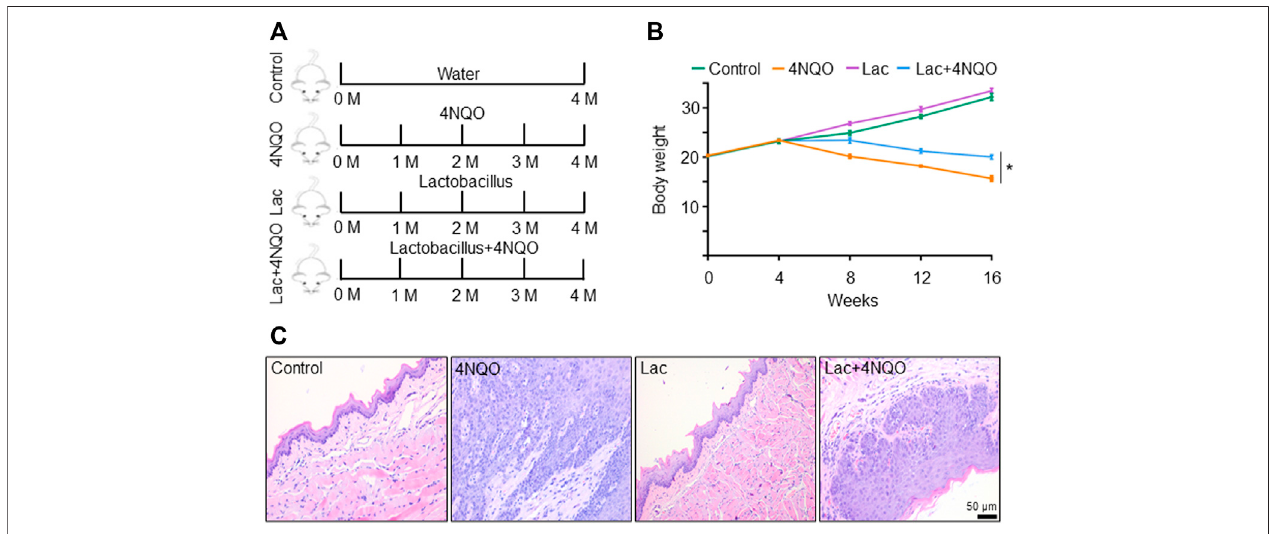
FIGURE 3 | Supplementof Lactobacillus slowsdownOPCtumorigenesis.Miceweretreated asdescribed in Figure 1 . 2× 10 9 CFU of Lactobacillus in0.2 mlPBSor PBS alone was dripped into the mouth of mice treated with 4NQO for 16 weeks. Five mice were randomly sacri fi ced every 4 weeks continuously for 16 weeks. (A) Experimental procedures. (B) Body weightofmice. (C) HE stainingofglossopharyngeal tissue. Datarepresent mean± SEM.* p < 0.05, n = 5,comparedwith4NQOalone.